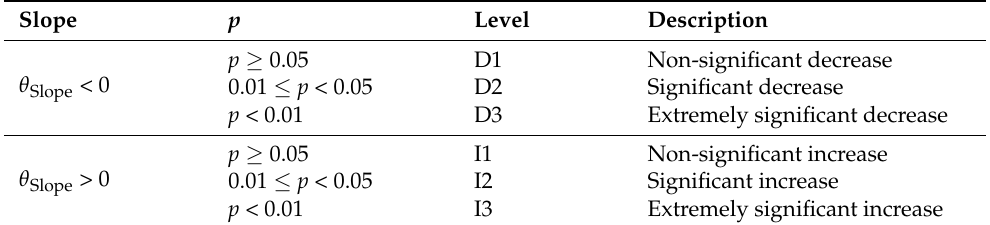
Table 3. Slope and significance